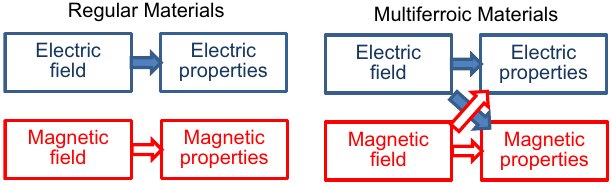
Figure 10. Uncoupled magnetic and electric properties of the ferroelectric and ferromagnetic materials are depicted to the left and the coupled magnetic and electric properties of magnetoelectric materials are depicted to the right